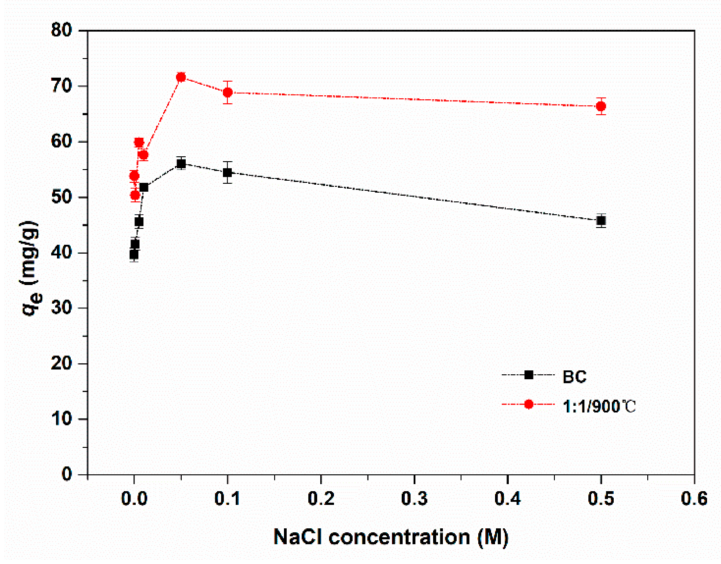
Figure 7. E ff ect of ionic strength on E2 removal by BC and 1:1 / 900 ◦